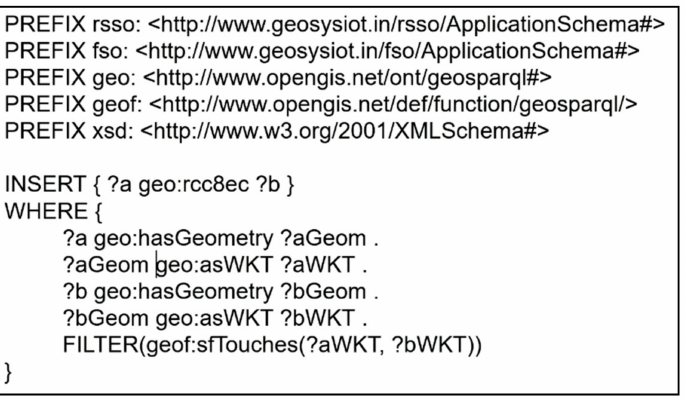
Figure 7. GeoSPARQL query depicting inferencing of externally connected topological relationship, using GeoSPARQL’s geof:sfTouches